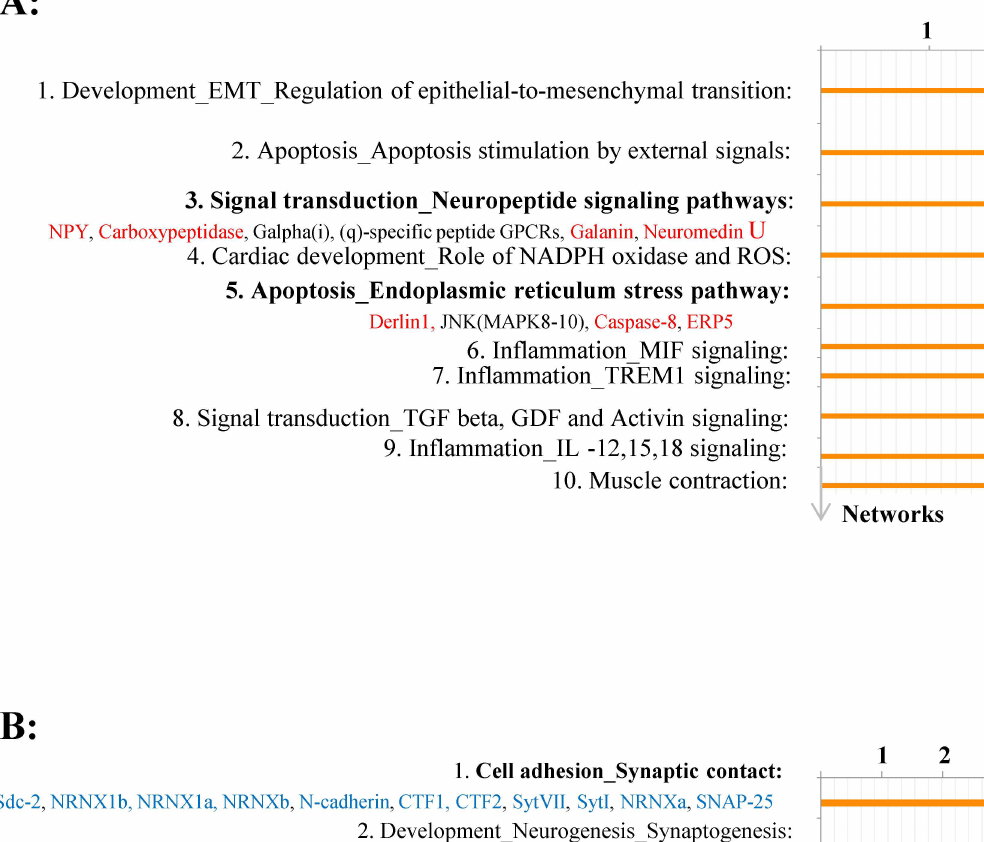
PLOS ONE | DOI:10.1371/journal.pone.0173839 March 8,